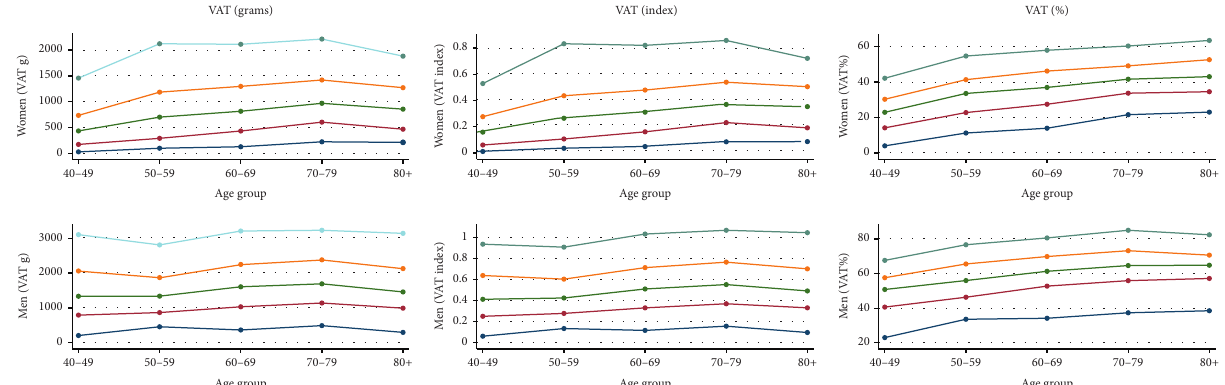
Figure 4: Quantities of VAT (g), VAT (index), and VAT (%) in 10-year age groups in women and men: the Tromsø Study